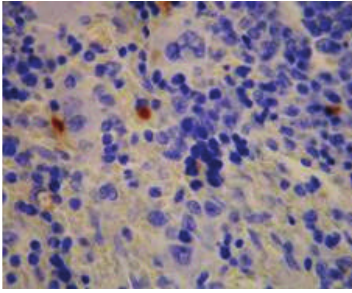
Figure 6: Model control group—28 days in OJ experiment spleen (several apoptoic cells), TUNEL × 400.